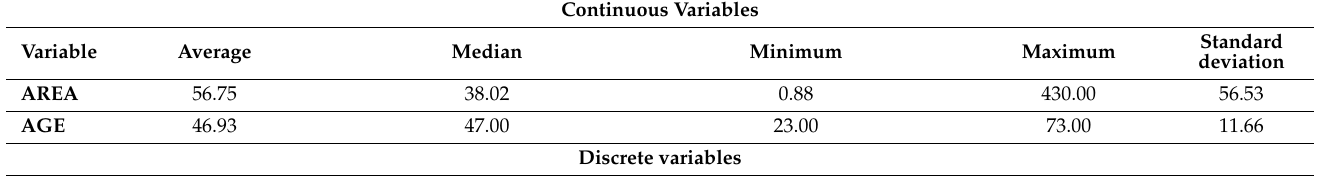
Table 2. Descriptive statistics of independent variables considered in the